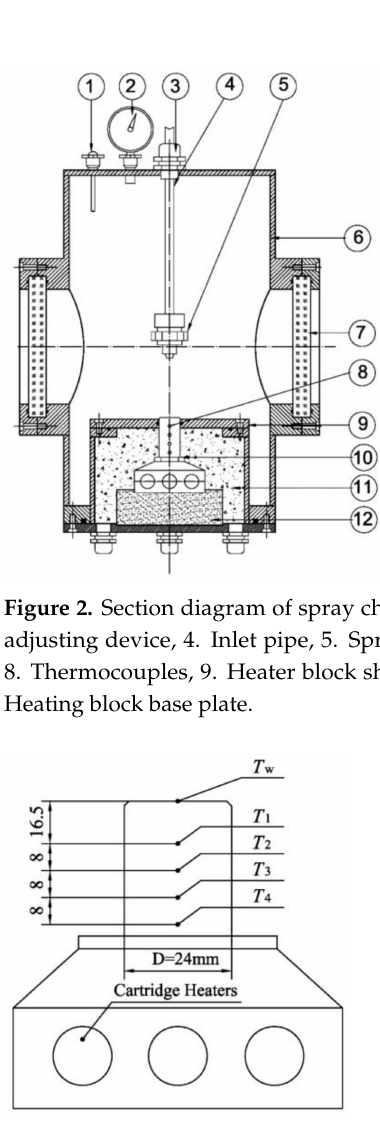
Figure 3. The heating block and the thermocouples.